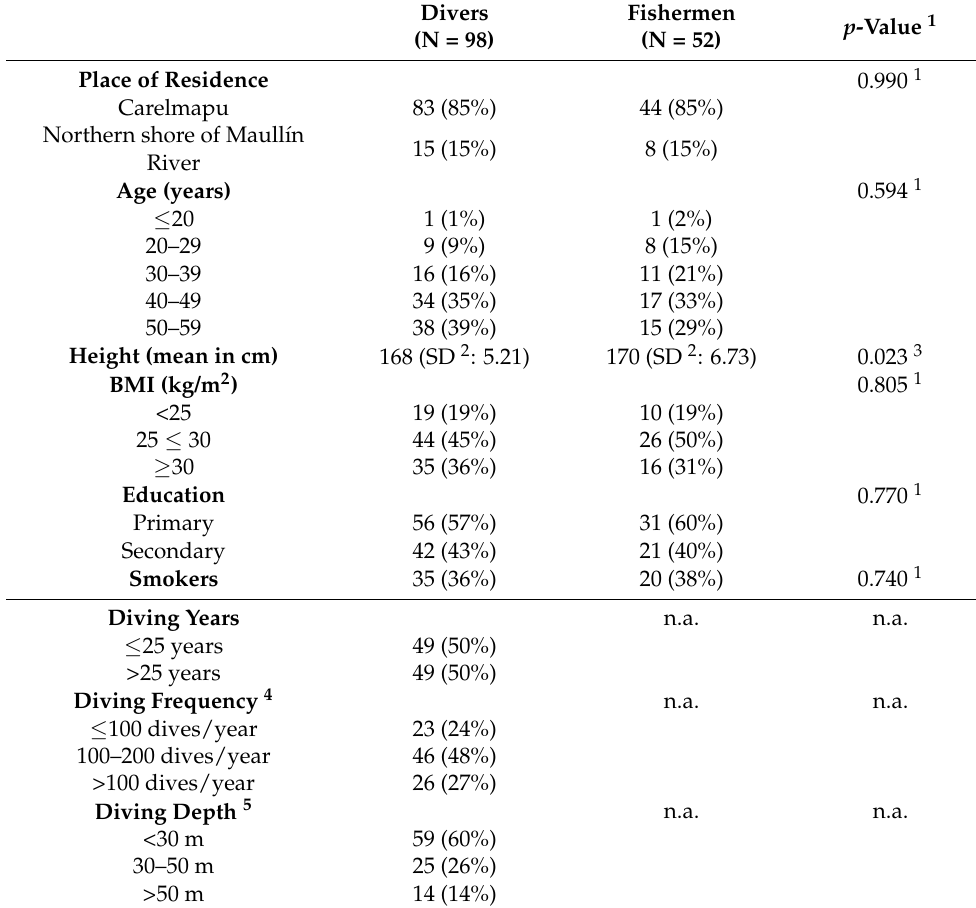
Table 1. Demography and health status of the divers and fishermen.